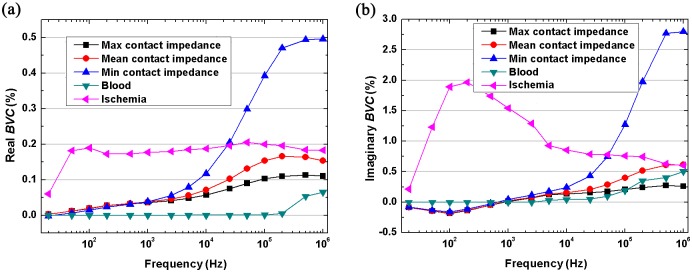
The boundary voltage changes (BVC) caused by three levels of contact impedance, ischemic stroke and hemorrhagic stroke.